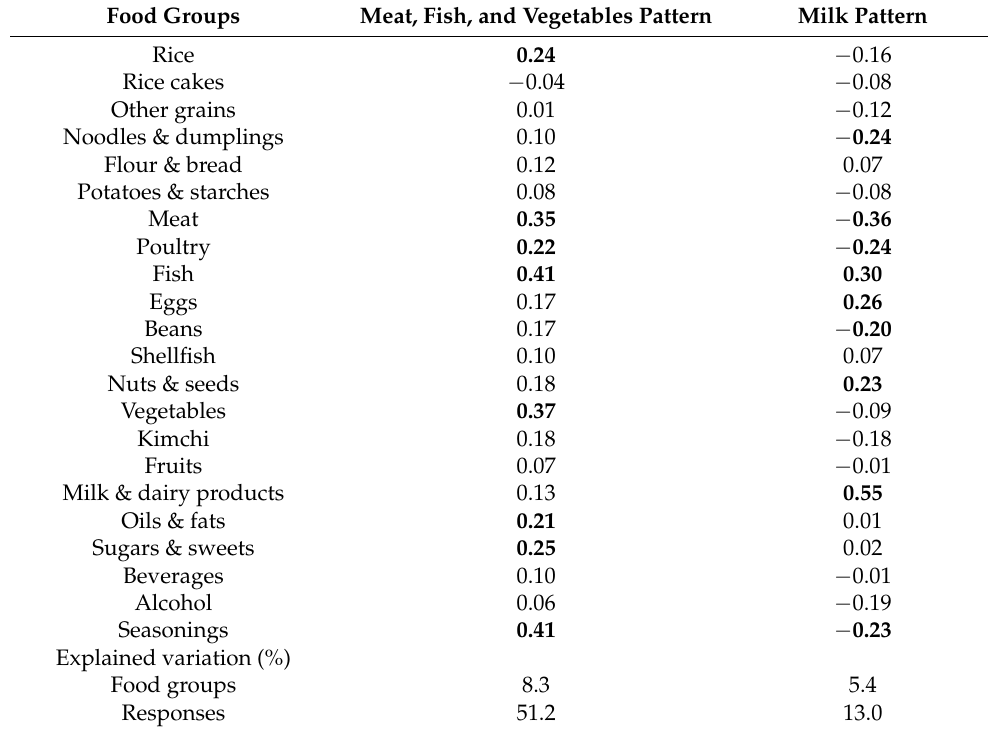
Table 1. Factor loading values derived by reduced rank regression a ( n = 511). Food Groups Meat, Fish, and Vegetables